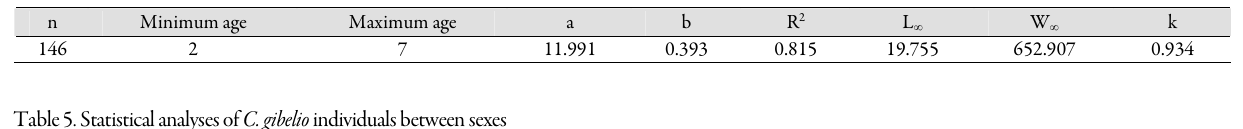
Table 4. C. gibelio length and age parameters